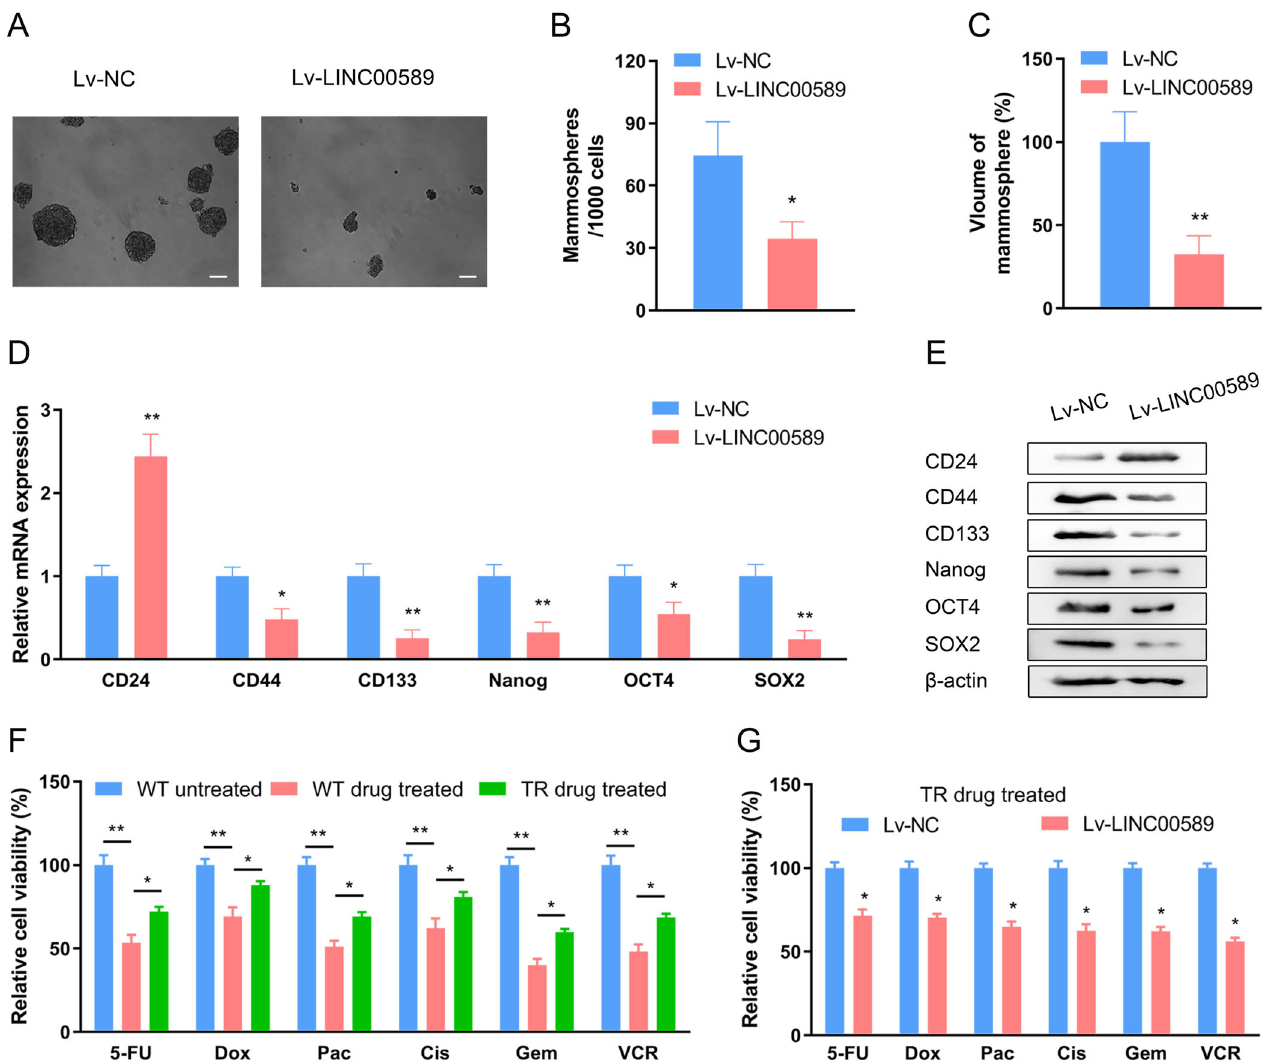
Fig. 3 LINC00589 expression reverses cancer stem cell-like properties and multiple chemoresistance of HER2-positive breast cancer. A Representative image of mammosphere formation in NC- and LINC00589 - overexpressing TR breast cancer cells. Scale bar 100 μ m. B , C Quanti fi cation of the mammosphere number ( B ) and volume ( C ). Data are shown as the mean ± SD of fi ve random high-power fi elds (HPF), and were analyzed by two-tailed t test. * P < 0.05, and ** P < 0.01. D , E TR cells were infected with NC lentivirus or Lv-LINC0089. mRNA and protein levels of molecular markers of breast cancer CSC-like properties were determined by qRT-PCR assay ( D ) and western blotting assay ( E ). Data are shown as the mean ± SD and were analyzed by Student ’ s unpaired two-tailed t test. * P < 0.05, and ** P < 0.01. F , G WT cells, TR cells, and TR cells infected with NC- or LINC00589 -overexpressing lentivirus were treated with 5-FU, doxorubicin (Dox), paclitaxel (Pac), cisplatin (Cis), gemcitabine (Gem), or vincristine (VCR) for 48 h. The relative cell viability was tested by CCK-8 assay and normalized to non-treated cells. Data are shown as mean ± SD and were analyzed by two-tailed t test. * P < 0.05, and ** P < 0.01 versus negative control